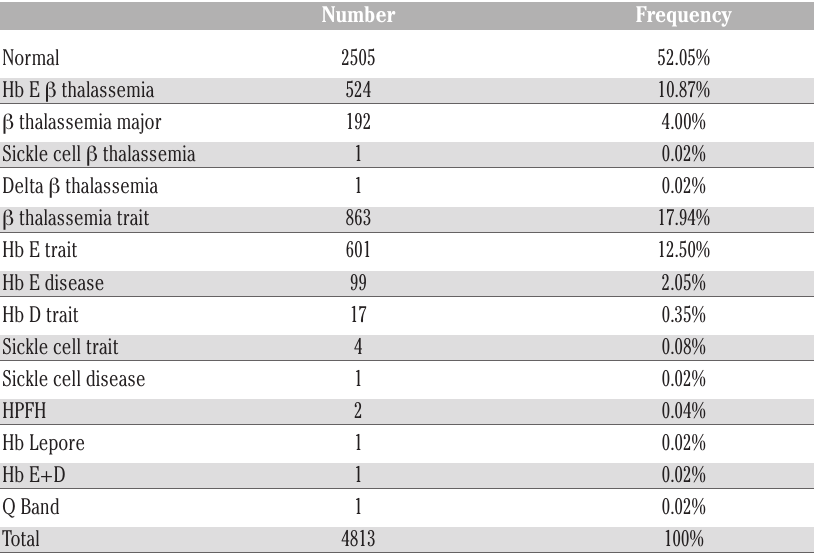
Table 1. Spectrum of thalassemias and